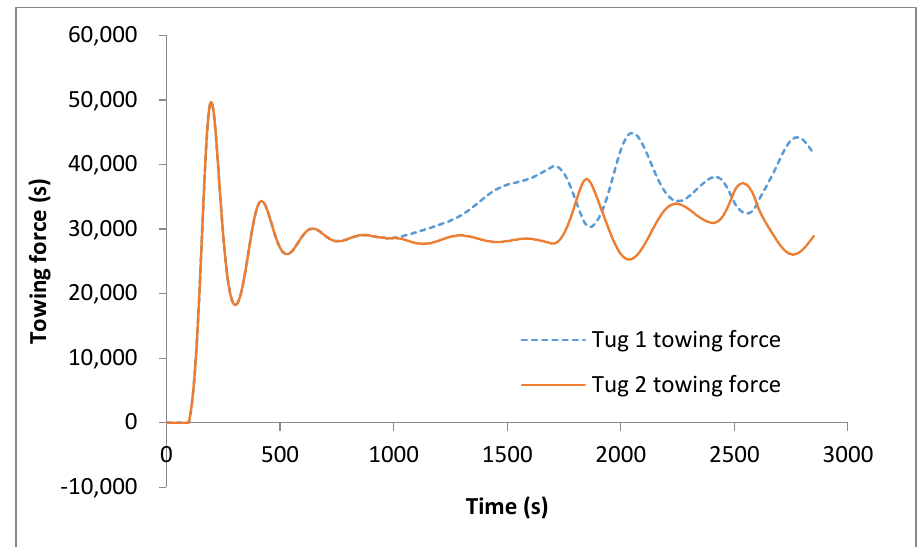
Figure 10. Cable force analysis of tugboat under turning condition of towage system.